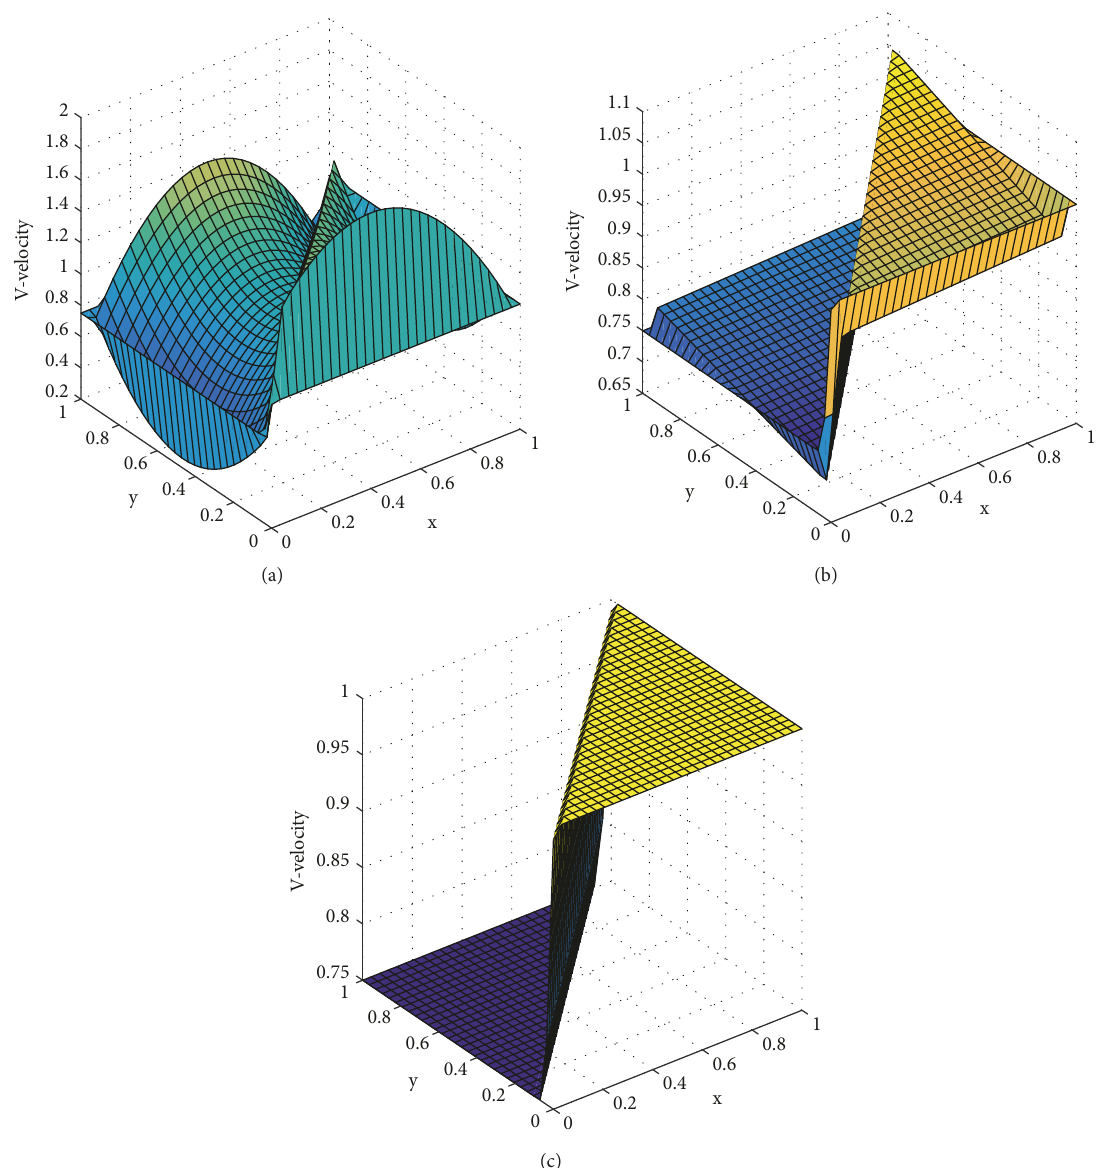
Figure 11: V-velocity profile at Re = 1,300 with 𝜀 = 0.005,𝑡 = 0.5,Δ𝑡 = 0.0005, 𝑁 = 30 × 30 ; (a) Conventional Kansa, (b) Hermite scheme, and (c) exact